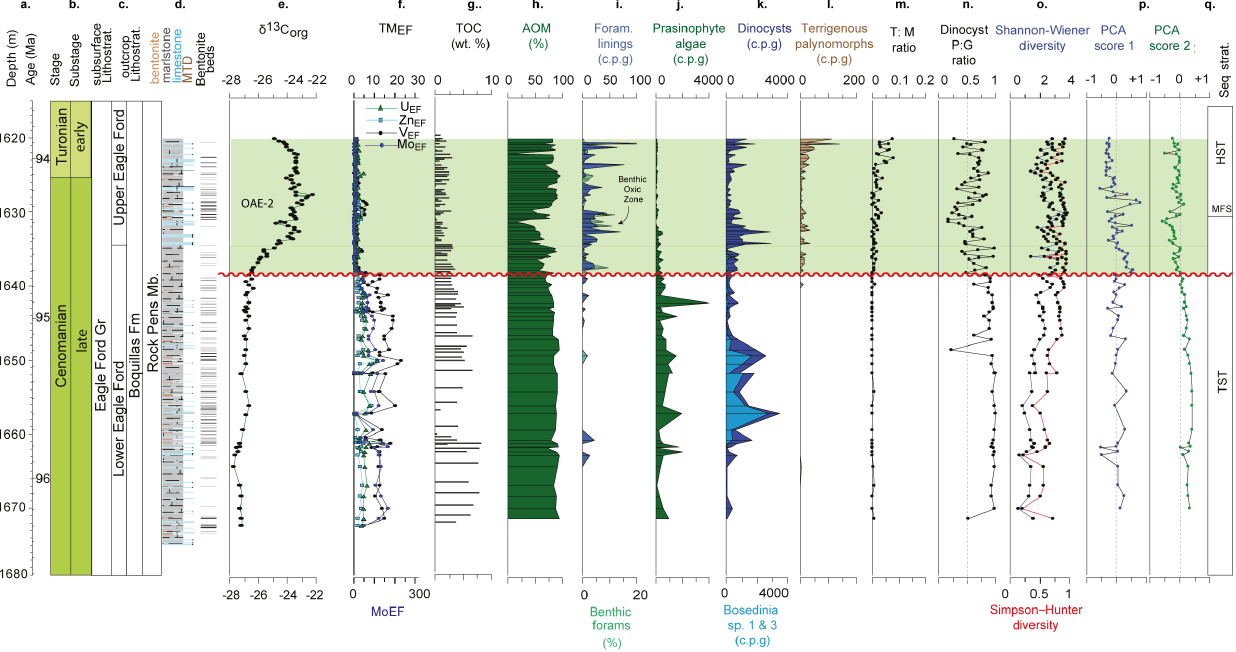
Figure 6. Well “X” core data. Legend same as Fig.